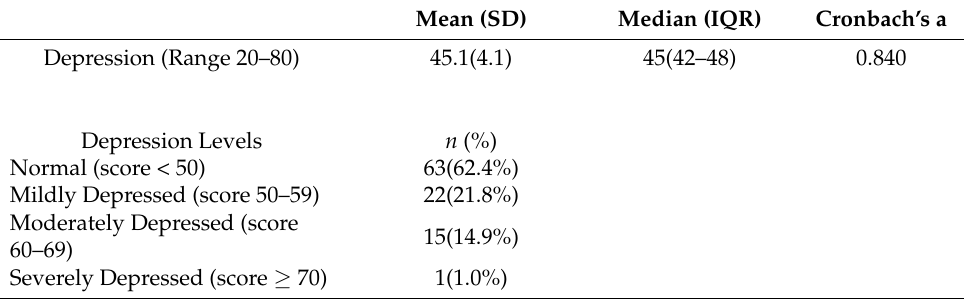
Table 5. Measuring the depression of inmates ( n =